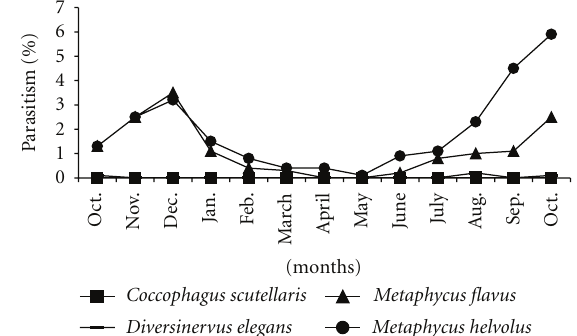
Figure 8: Percent parasitism of Coccophagus scutellaris and other associated parasitoid of Pulvinaria floccifera on mango in Sharqiya governorate before releasing during 2009-2010.